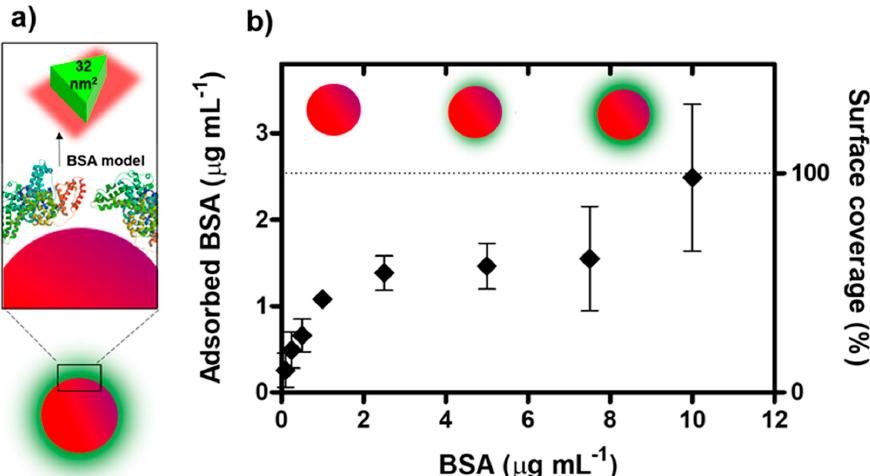
Figure 1. Protein corona formation. ( a ) Illustration of the bovine serum albumin (BSA) corona and BSA molecules approximated by an equilateral triangular prism (not drawn to scale). ( b ) Adsorption isotherm of BSA onto gold nanoparticles (AuNPs) (left y-axis), and estimated percentage of AuNP surface coverage as a function of the BSA concentration (right y-axis) (error bars represent the standard deviation, n =